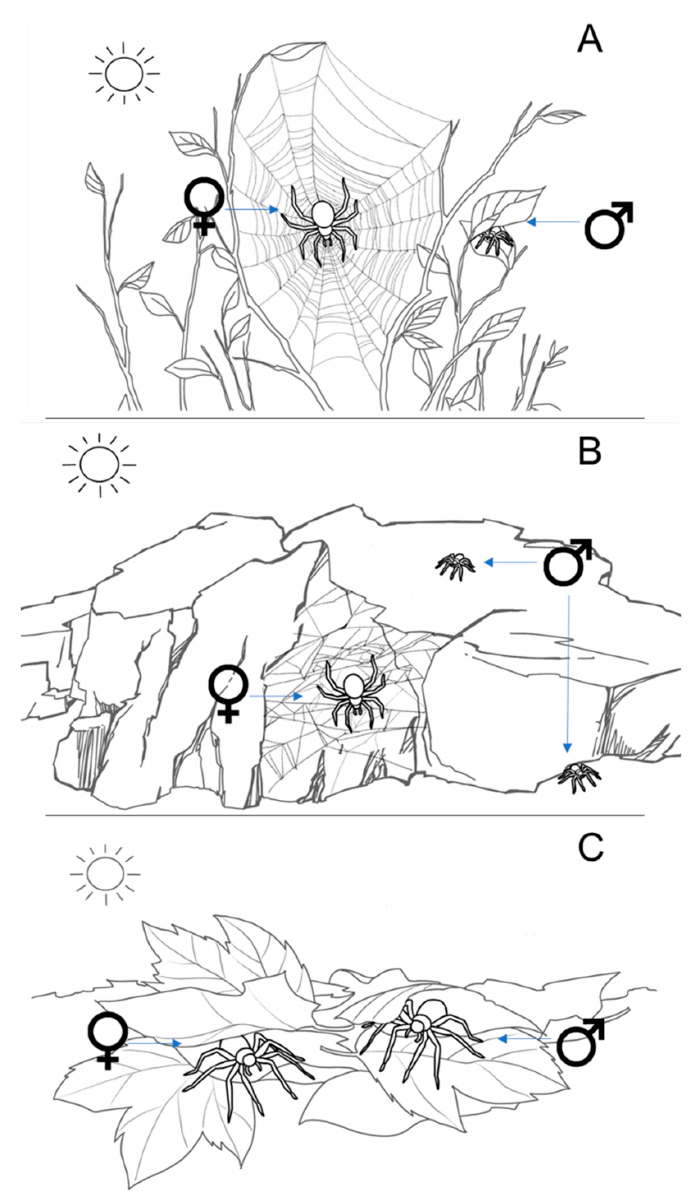
Figure 3. Illustration showing the differing biology and behavioral strategies of spiders in response to habitats with variable exposure to direct sunlight. Many species of web-building spiders ( A , B ) show significant female-biased sexual size dimorphism (SSD), and males and females may also exhibit discernible differences in behavior and ecology. In ( A ), orb-web-building adult female spiders (Araneidae) construct their large webs in open habitats and are thus often exposed to hot and bright conditions. Adult males, on the other hand, do not construct webs and instead spend most of their time searching for mates. This means they have much larger niches, which gives them the opportunity to seek shelter under rocks, bark or the canopy of plants during the day or when abiotic conditions are unfavorable. In ( B ), tangle-web weaving adult female spiders (Theridiidae) construct small webs under rocks or in crevices which are perpetually shaded. Males also frequent these habitats but may need to temporarily move into more exposed locations to search for mates. Alternatively, some non-web building spiders do not show significant SSD, and both sexes exhibit similar biology and ecology. In ( C ), male and female wolf spiders (Lycosidae) co-occur in the same microhabitats, and both sexes forage and search for mates when abiotic conditions are